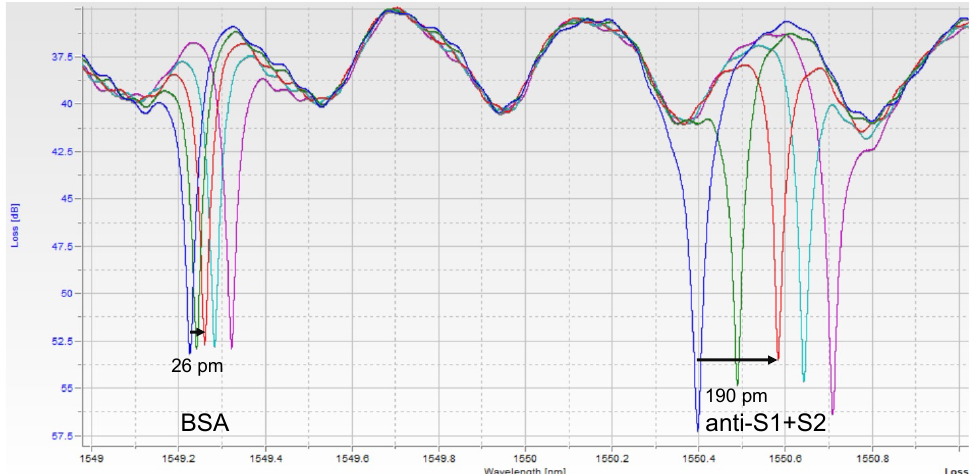
Figure 2. Single Assay Raw Photonic Spectra. Each peak corresponds to one of the ring resonators. As the sample binds to each ring, the resonant wavelength redshifts. The BSA-functionalized (control) ring shifts a small amount due to bulk refractive index changes and non-specific binding of serum components, while the anti-S1+S2-functionalized ring shifts more as spike protein binds to it specifically. The different color spectra here represent increasing timepoints, t = 0, 1, 3, 5, and 7 min. At t = 3 min, the shift of each peak is measured, and the control ring is subtracted from the experimental ring to obtain a relative shift indicative of analyte binding.